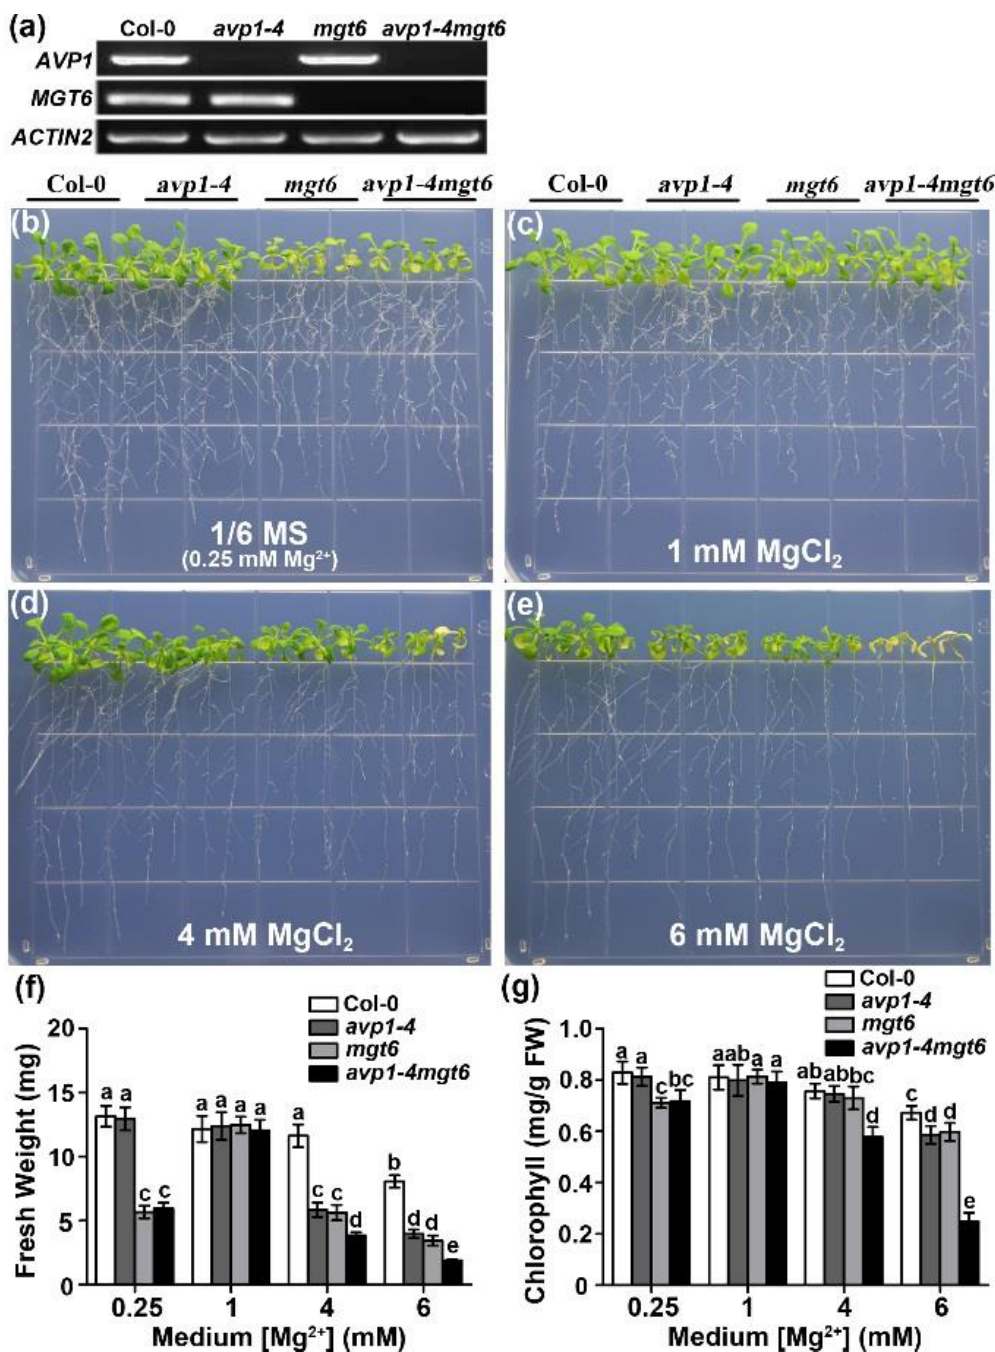
Figure 5. Phenotypic analysis of Mg 2+ sensitivity in the avp1-4 mgt6 double mutant. ( a ) RT-PCR analysis of AVP1 and MGT6 gene expression in wild-type Col-0, homozygous avp1-4 or mgt6 single mutant and the avp1-4 mgt6 double mutant. ( b – e ) Phenotypic analysis of Mg 2+ sensitivity in avp1-4 , mgt6 , and avp1-4 mgt6 mutants. ( f ) Fresh weight of seedlings on the 10th day after transfer. ( g ) Chlorophyll content of seedlings on the 10th day after transfer. Data are mean ± SD from triplicate experiments. Any pair of genotypes/treatments that do not share the same letter are significantly different ( p < 0.05) based on a Duncan’s multiple range test.